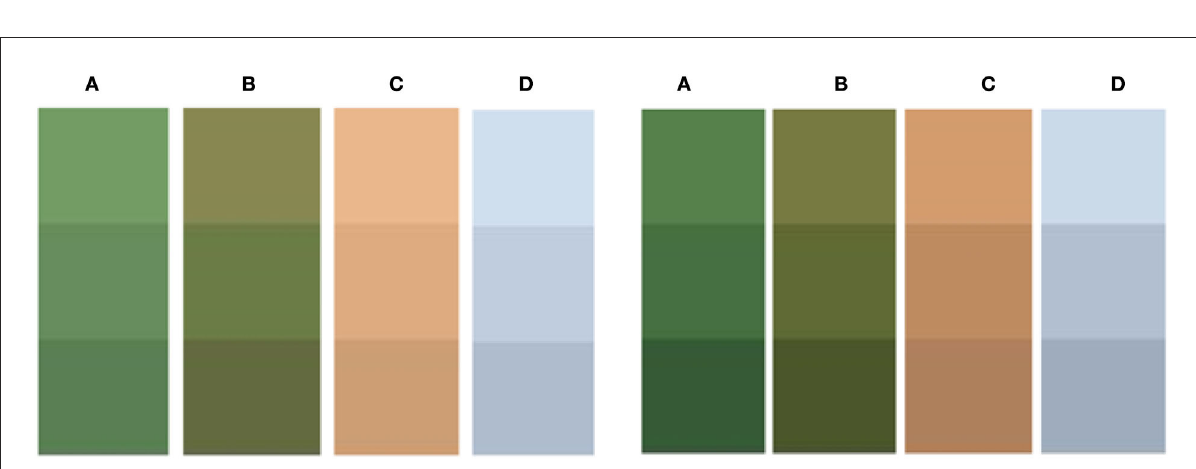
FIGURE9 Max pooling-Laplacian pre-processed primary color and un-pre-processed primary color (A) woodland background; (B) grassland background; (C) desert background; and (D) snow